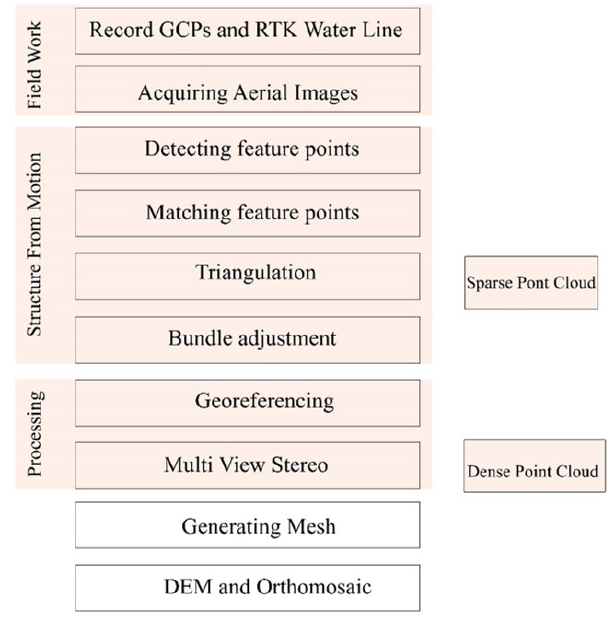
Figure 6. Photogrammetry process from image collection to recon- struction of elevation model adapted from Balogh and Kiss